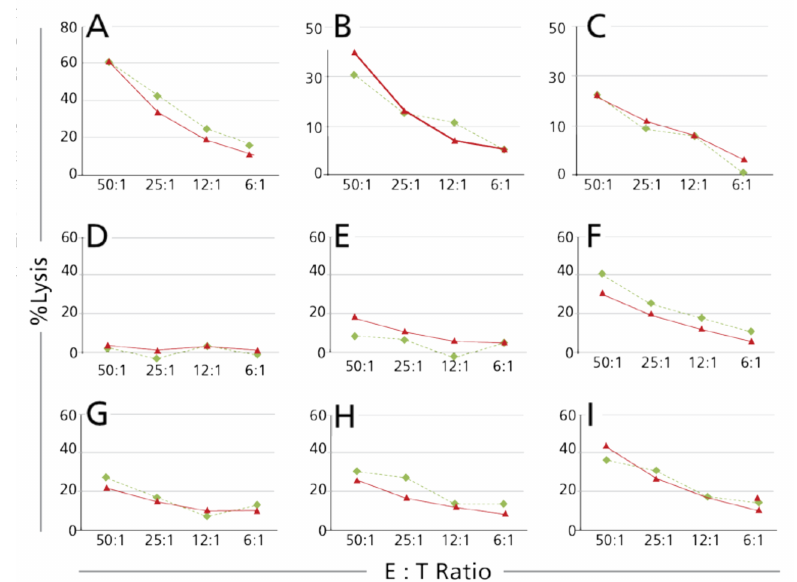
Figure 3. Comparing Calcein TVA with chromium release assay as the compendial method. The two assays were performed in parallel using the same PBMC, at the same effector to target (E:T) ratios and using the same numbers of K562 target cells. Each test condition was done in triplicate wells with the mean and standard deviation (SD) for these replicates shown. Red lines specify the results obtained with the chromium release assay, green lines those of the Calcein TVA assay. In Panels A – I , results are shown for individual donors, one in each